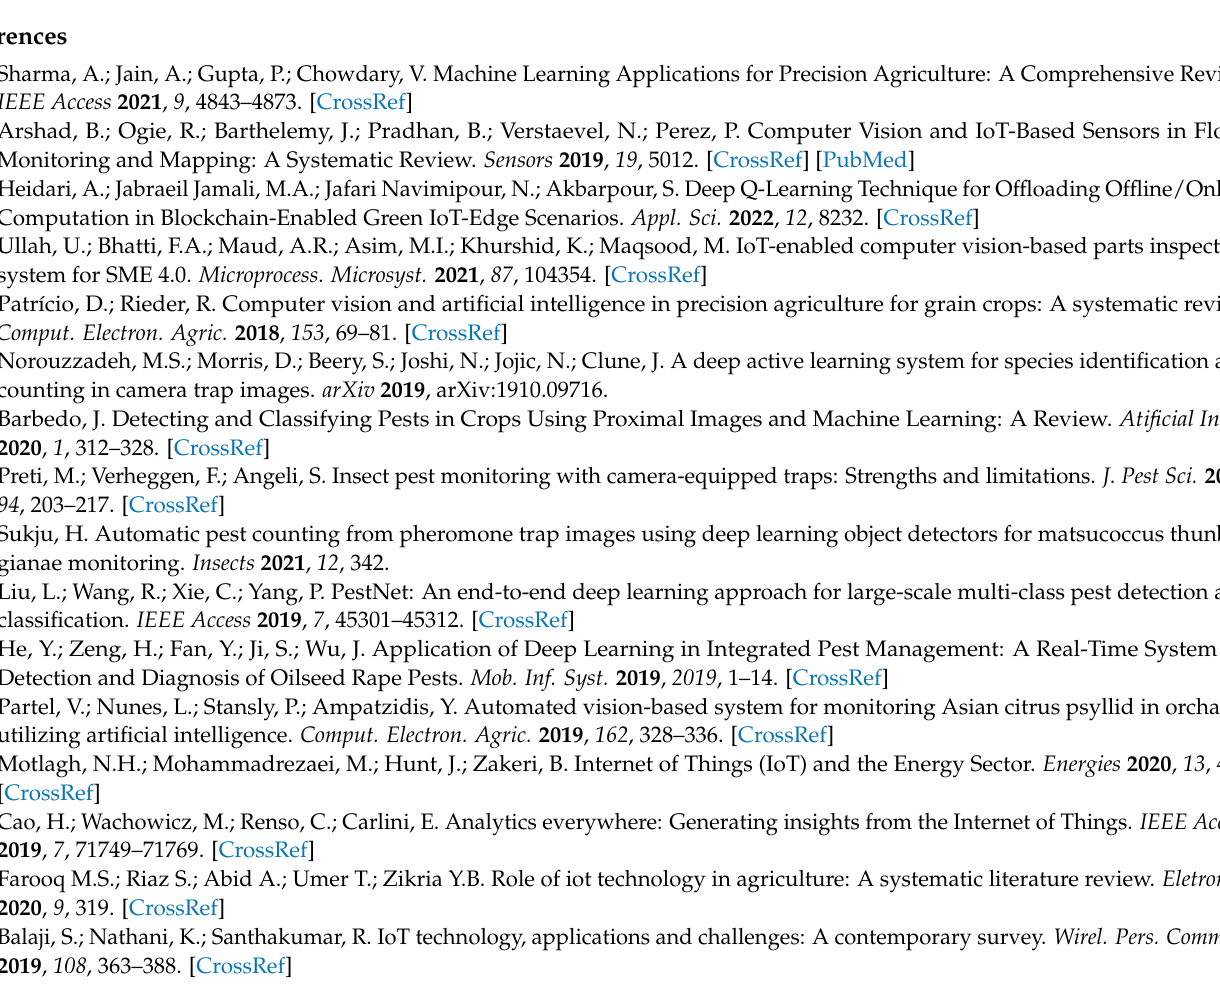
Figure A2. Another example of a daily pest detection by the CV